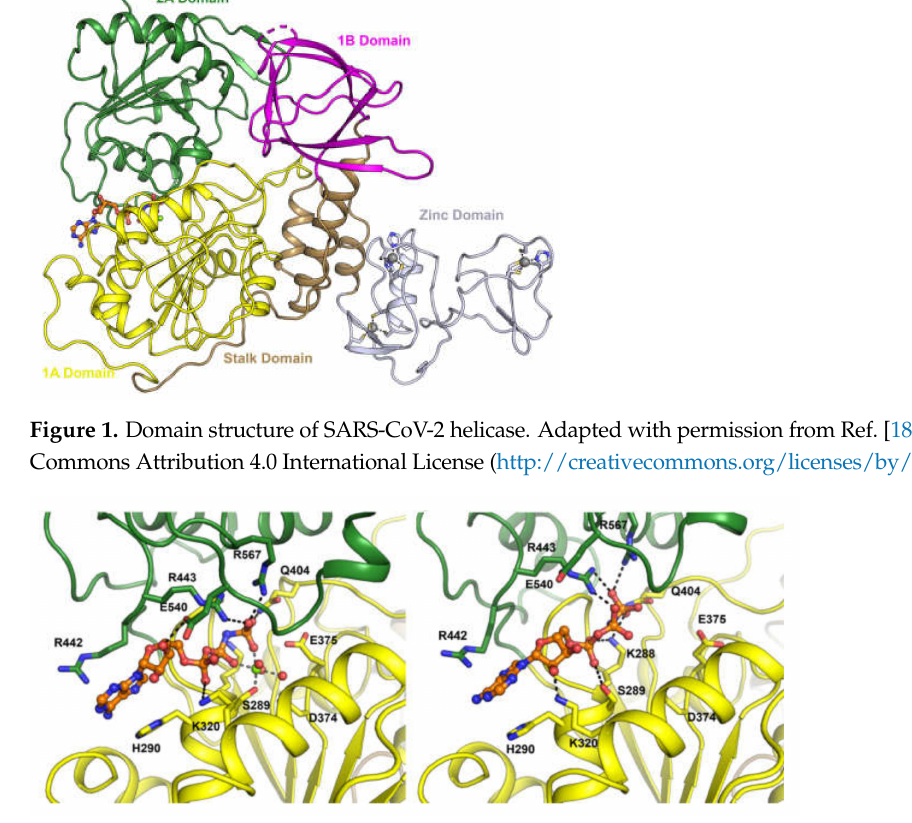
Figure 2. Key active ATP site residues for helicase bound to the AMP–PNP Mg2+ complex ( left ) and the AMP–PNP complex ( right ). Adapted with permission from Ref. [18]. Creative Commons Attribution 4.0 International License